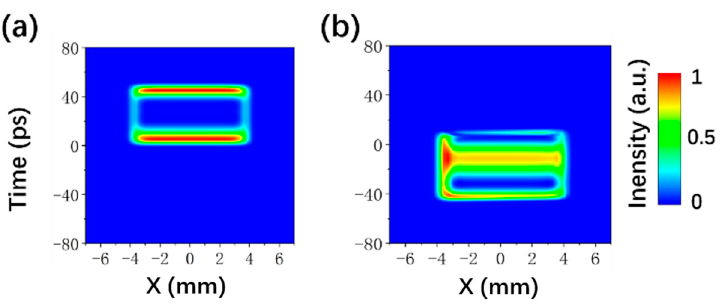
Figure 4. The temporal distributions of the residual pump along X axis for ( a ) OPA1 and ( b ) OPA2.